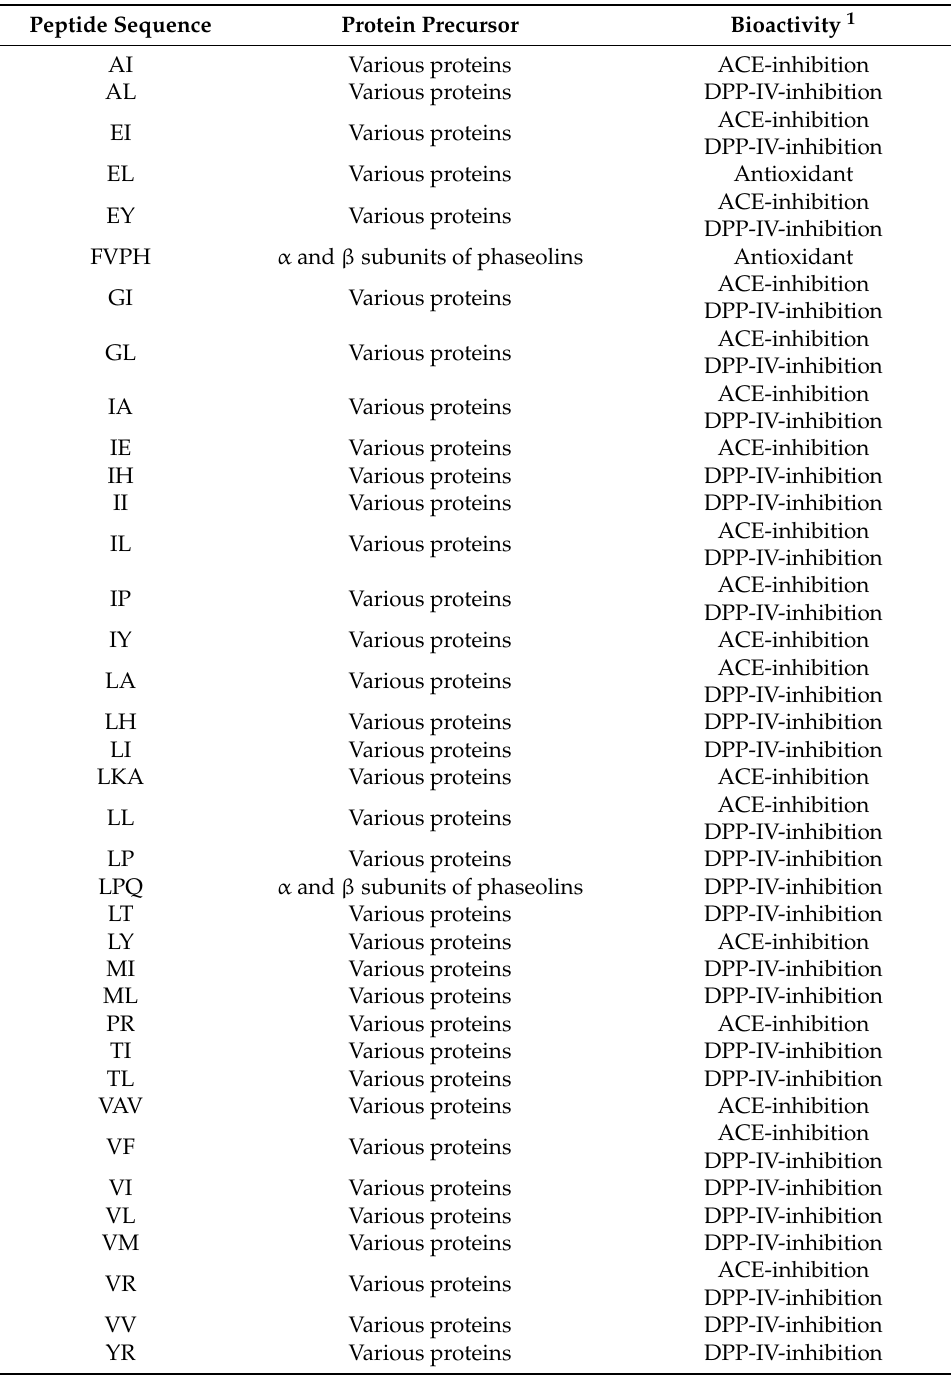
Table 1. Peptides with previously reported biological activity identified in in vitro-digested Pinto bean protein